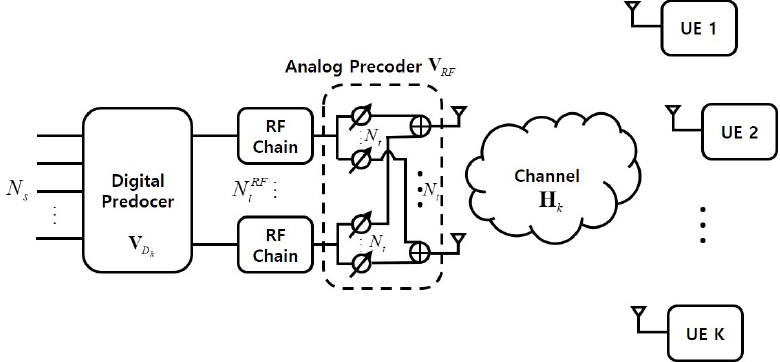
Figure 1. The architecture of fully connected structure hybrid beamforming system.